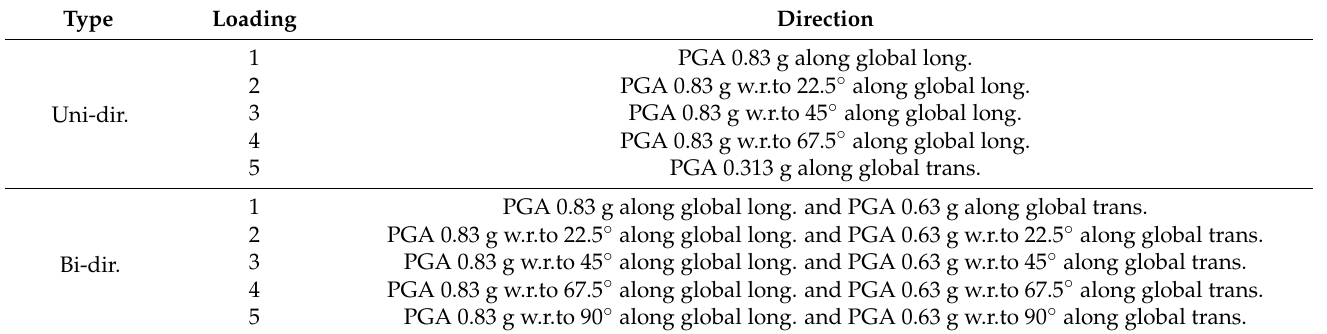
Table A2. Uni-directional and bi-directional loadings considered for Kobe ground motion.